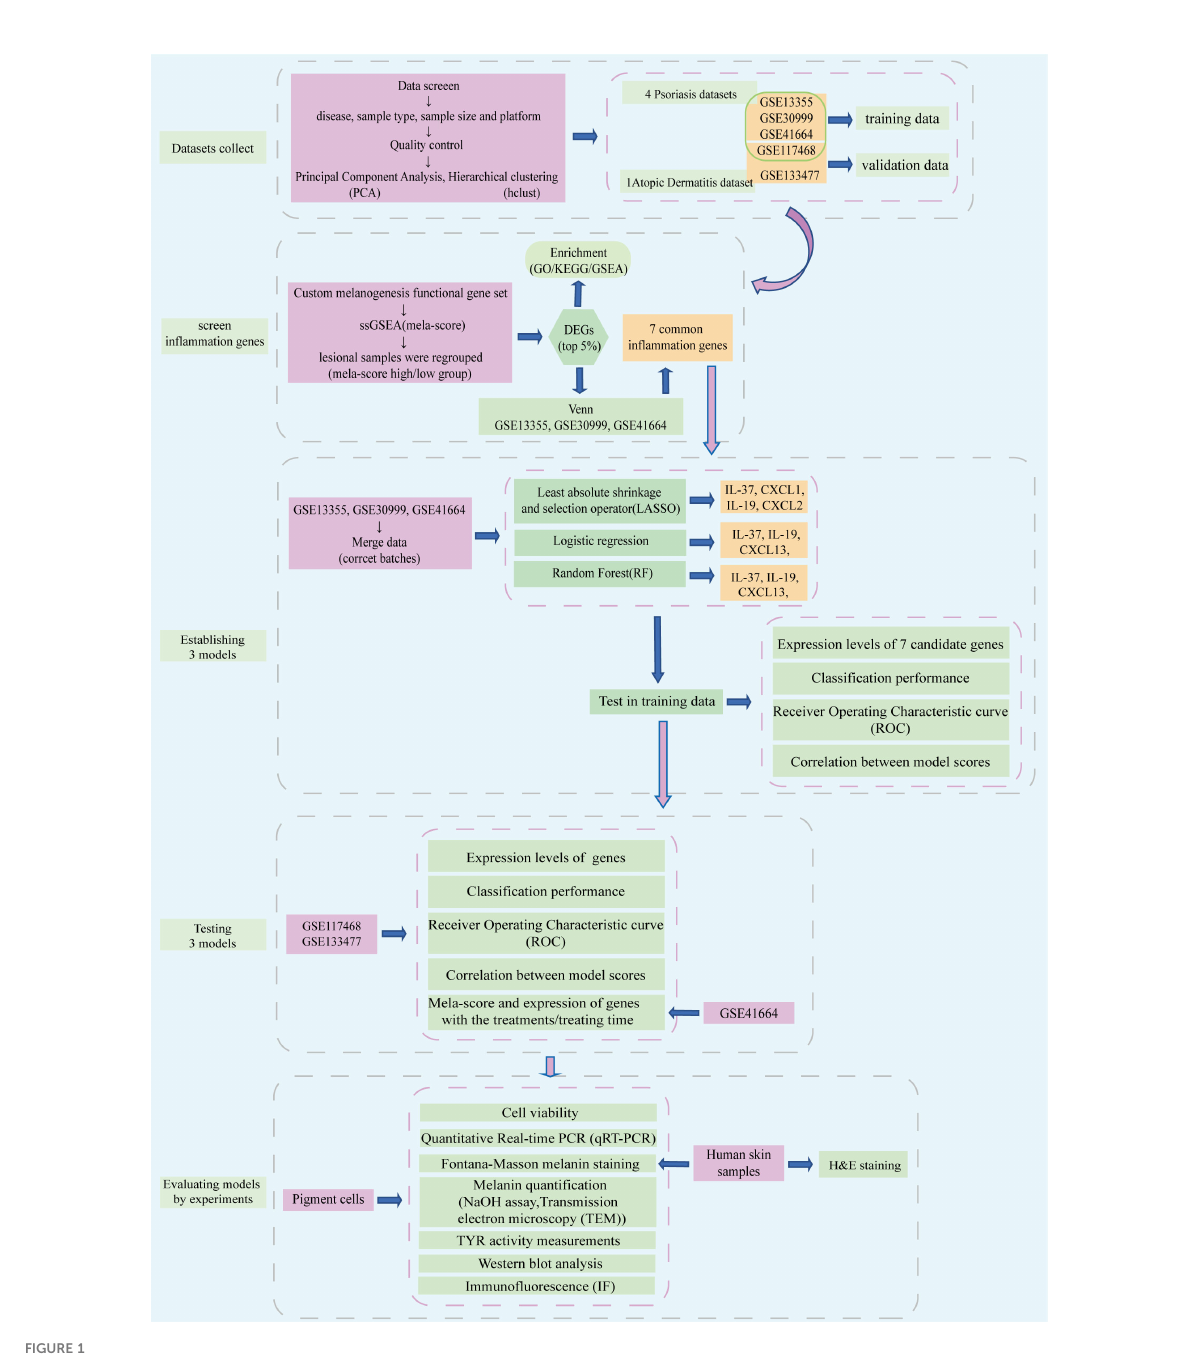
FIGURE 1 Flow chart of this